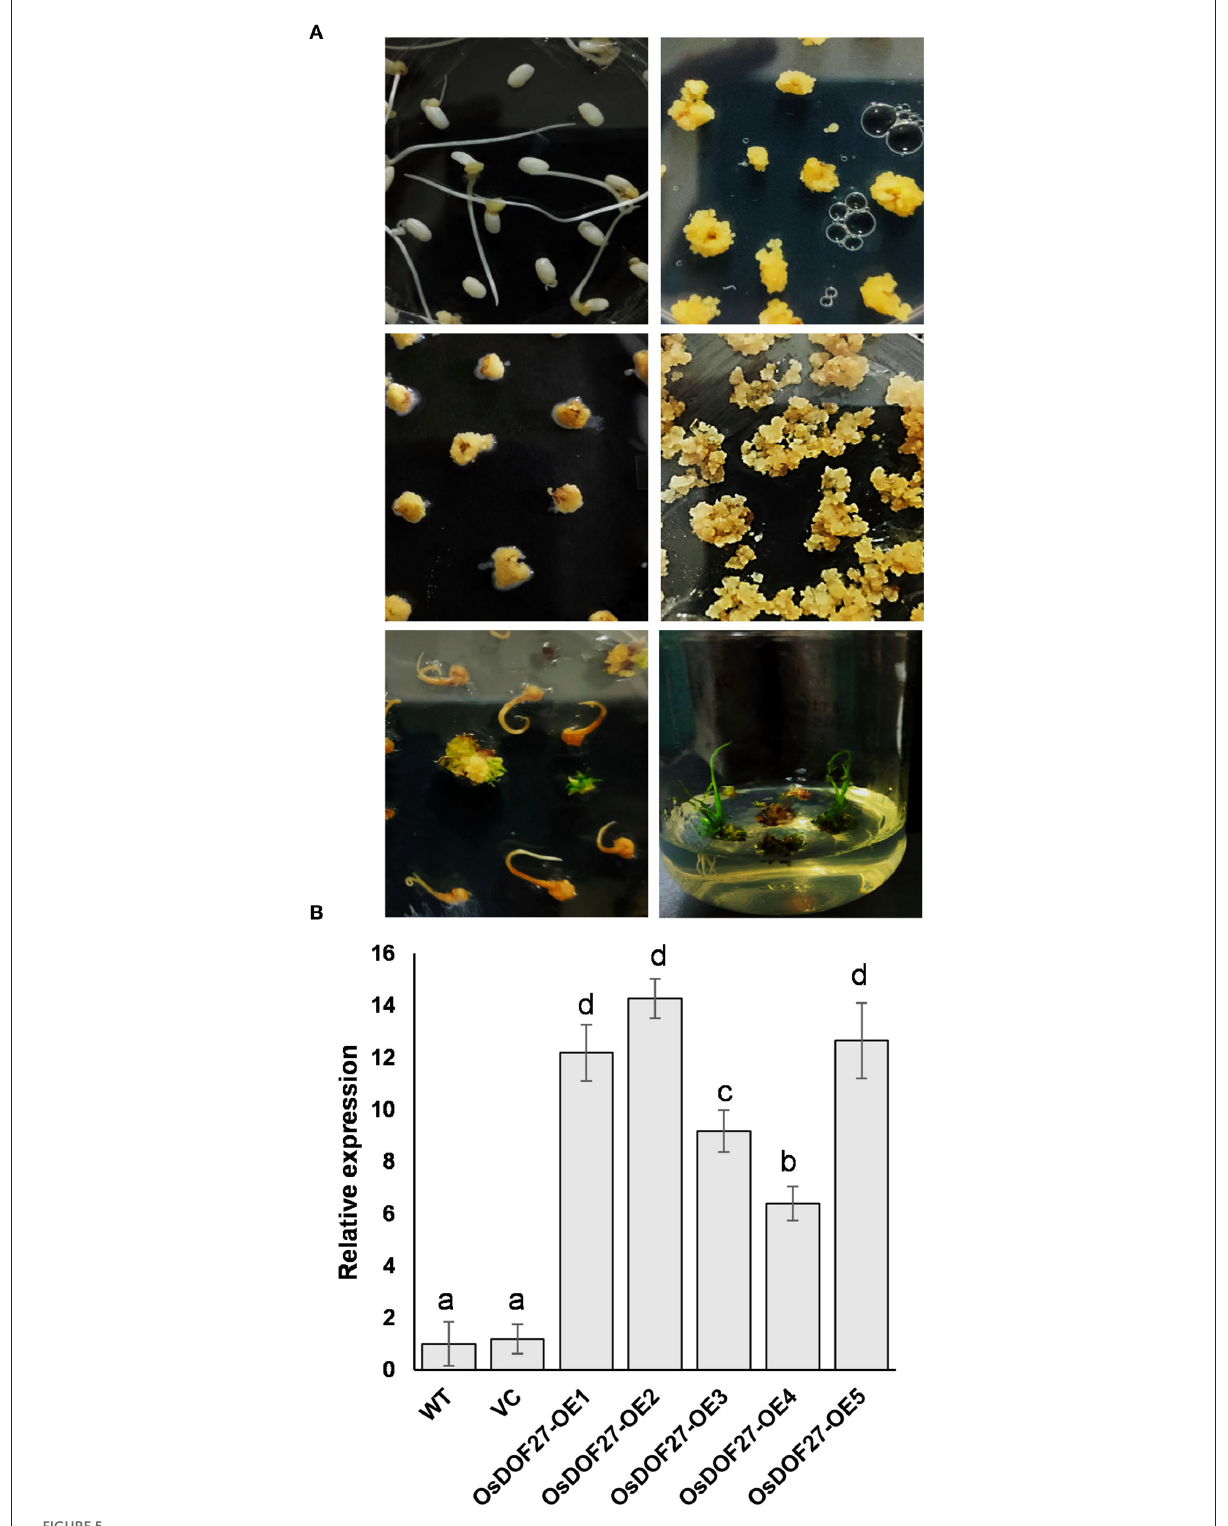
FIGURE5 (A) Schematic representation of the Agrobacterium -mediated rice transformation of OsDOF27 . (B) qPCR analysis of positive transformants. Total RNA was extracted from independent transgenic lines, and cDNA was synthesized followed by qPCR. Two endogenous controls (Ubiquitin-5 and EF1 α ) were used to normalize the relative expression value of OsDOF27 followed by calculation using the 11 CT method. The error bars represent the standard deviation of triplicate analysis. The significant difference in the mean of the values is indicated by different letters ( α =